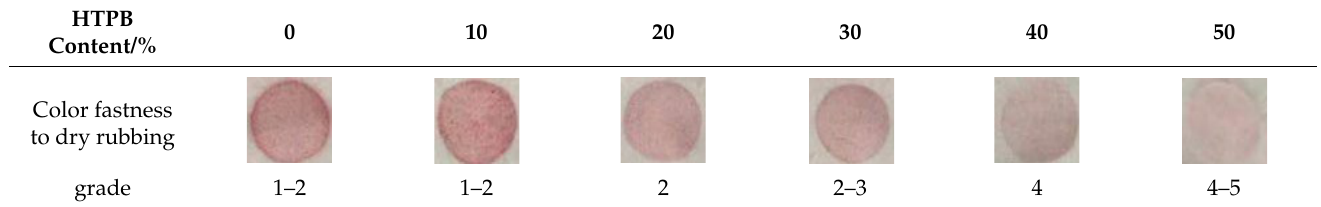
Table 11. Color binding upon dry rubbing of the modified microfiber leather.